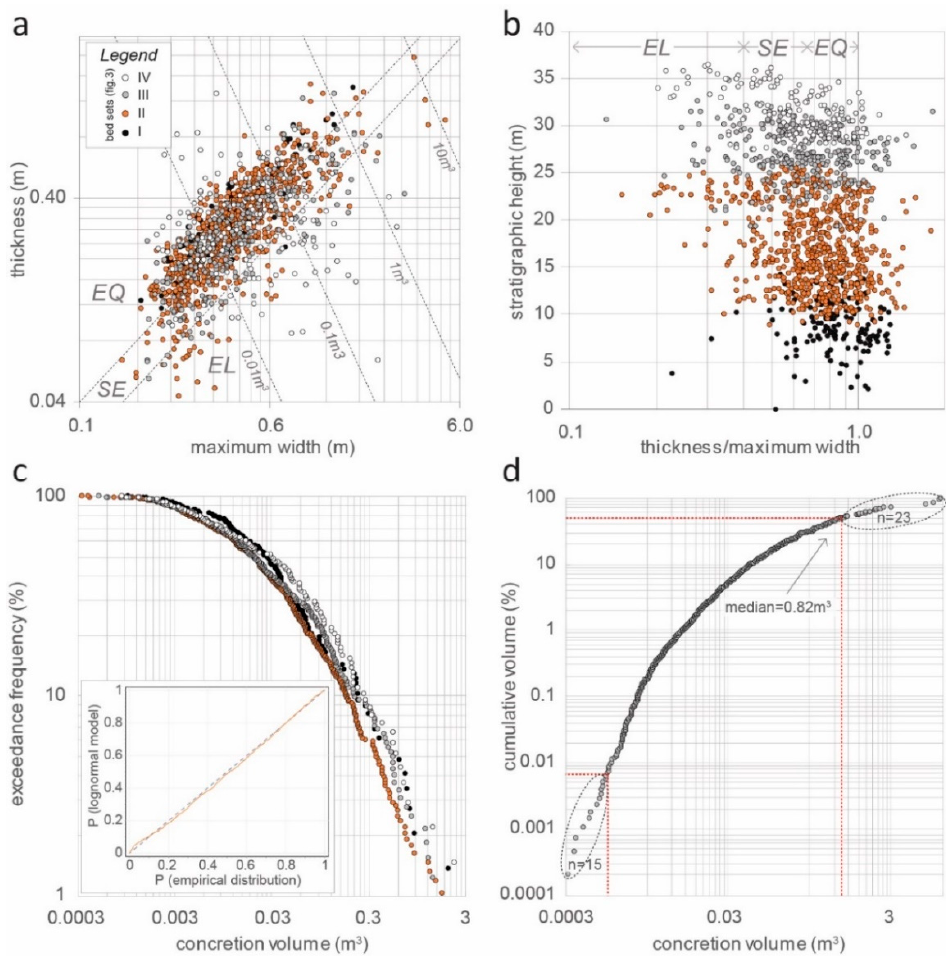
Figure 8. ( a ) Scatter plot of maximum width vs. thickness (logarithmic axes). The dashed lines delimit fields of equant (EQ), sub-equant (SE) and oblate (OB) shapes and volume rages; ( b ) Scatter plot of thickness to width ratio (logarithmic axis) vs. stratigraphic height; ( c ) Exceedance probability plot (logarithmic axes) of concretion volumes for bed sets I-IV with insert probability-probability indicating a lognormal model represents a good fit for the observed statistical distribution of concretion volumes; ( d ) Cumulative volume vs. volume (logarithmic axes) of concretions. Note how concretions with volume greater than 0.82 m 3 account for 50% of the total cemented sandstone volume, whereas concretions with volume less than 0.001 m 3 represent less than 0.0067% of the total volume. Data from 1286 concretions from bed sets I to IV (see legend) protruding from the steep to near-vertical outcrop faces of CdV.